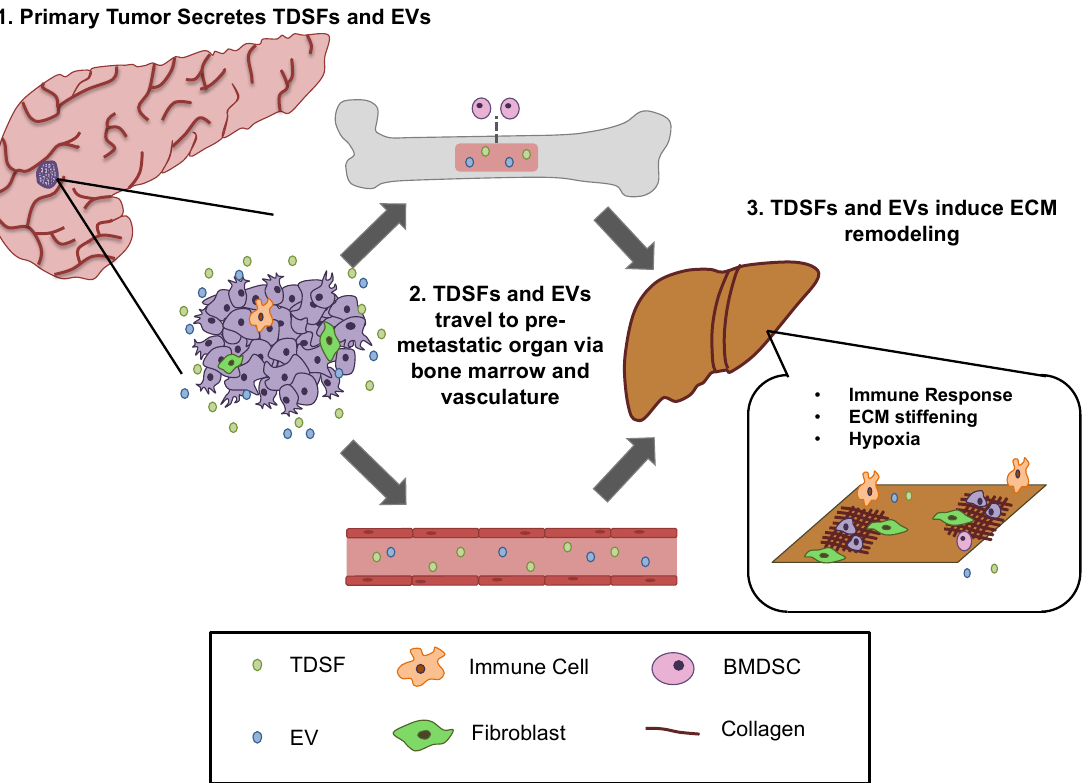
Figure 6. Illustration of pre-metastatic niche formation in the liver. ( 1 ) The primary tumour located in the pancreas emits tumour-derived secreted factors (TDSFs) and extracellular vesicles (EVs). ( 2 ) TDSFs and EVs migrate through the vasculature and bone marrow to the secondary organ. While in the bone marrow, TDSFs and EVs recruit bone marrow-derived stem cells (BDSCs), such as hematopoietic stem cells, to the secondary organ site. ( 3 ) TDSFs and EVs induce immune cell recruitment and ECM remodelling through LOX and cancer-associated fibroblasts at the pre-metastatic site. [220] One primary form of tumour-derived EV is the exosome, which has a diameter ranging